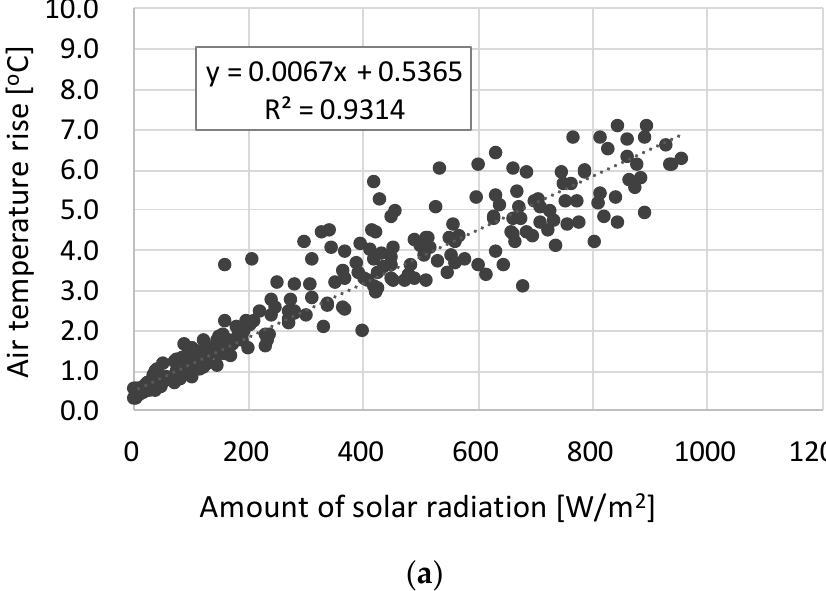
Figure 5. Outlet temperature of PVT panel: ( a ) summer; ( b ) winter.